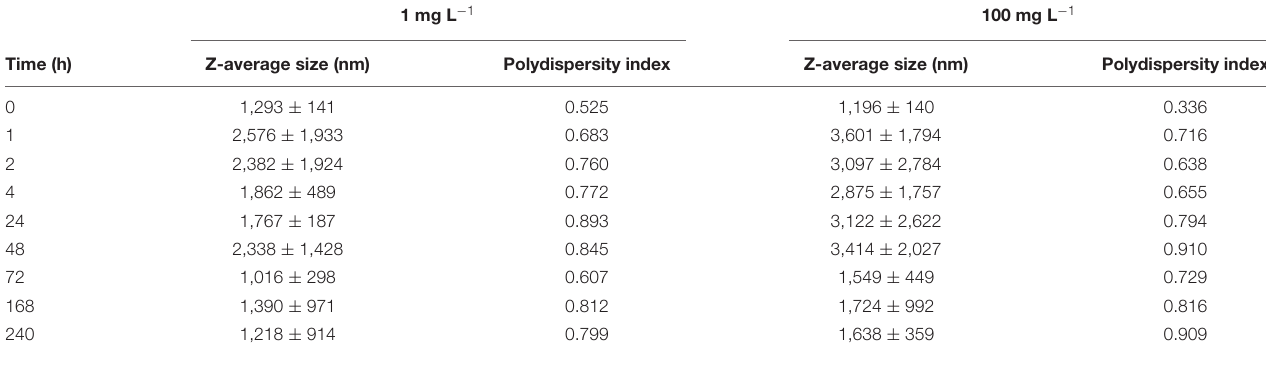
FIGURE 1 | Transmission electron microscope imaging of nCeO 2 (Sigma-Aldrich, < 25 nm) used for experimental work (A–C) . TABLE 1 | Summary of data obtained during DLS analysis of nCeO 2 (20.6 ± 12.1 nm) added to natural seawater for a period of 240 h at a concentration 1 and 100 mg L − 1 ( n =